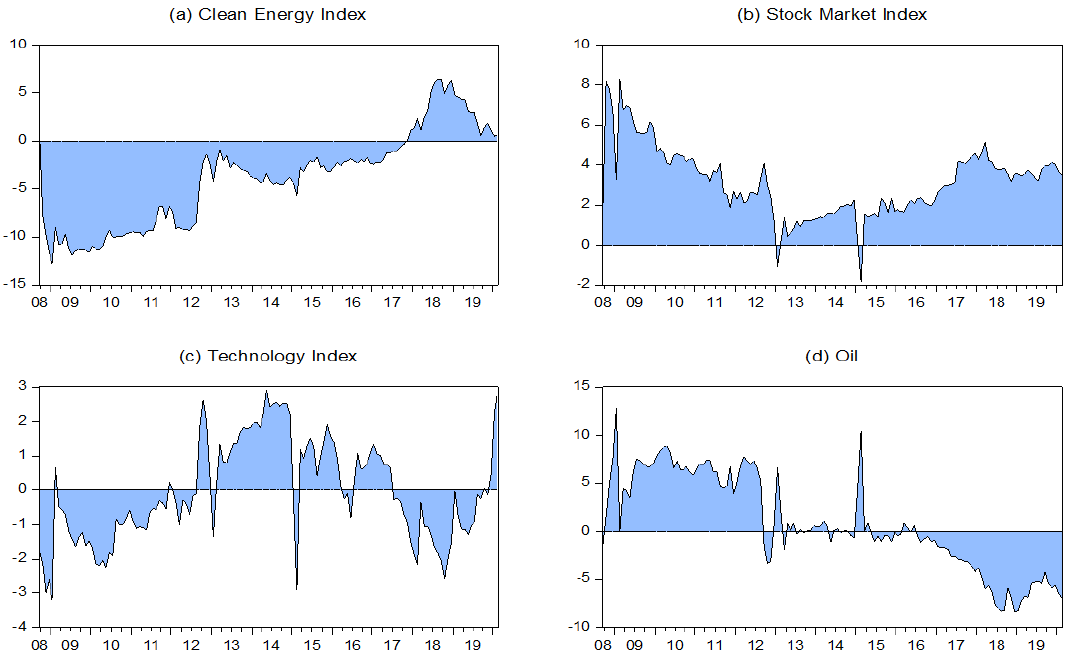
Figure 5. Net spillover among the clean energy (CE), S&P 500 (ST), technology (TE), and crude oil (WTI) series. Note: Positive values indicate transmitting spillover while negative values indicate receivers of spillover. The x -axis indicates the